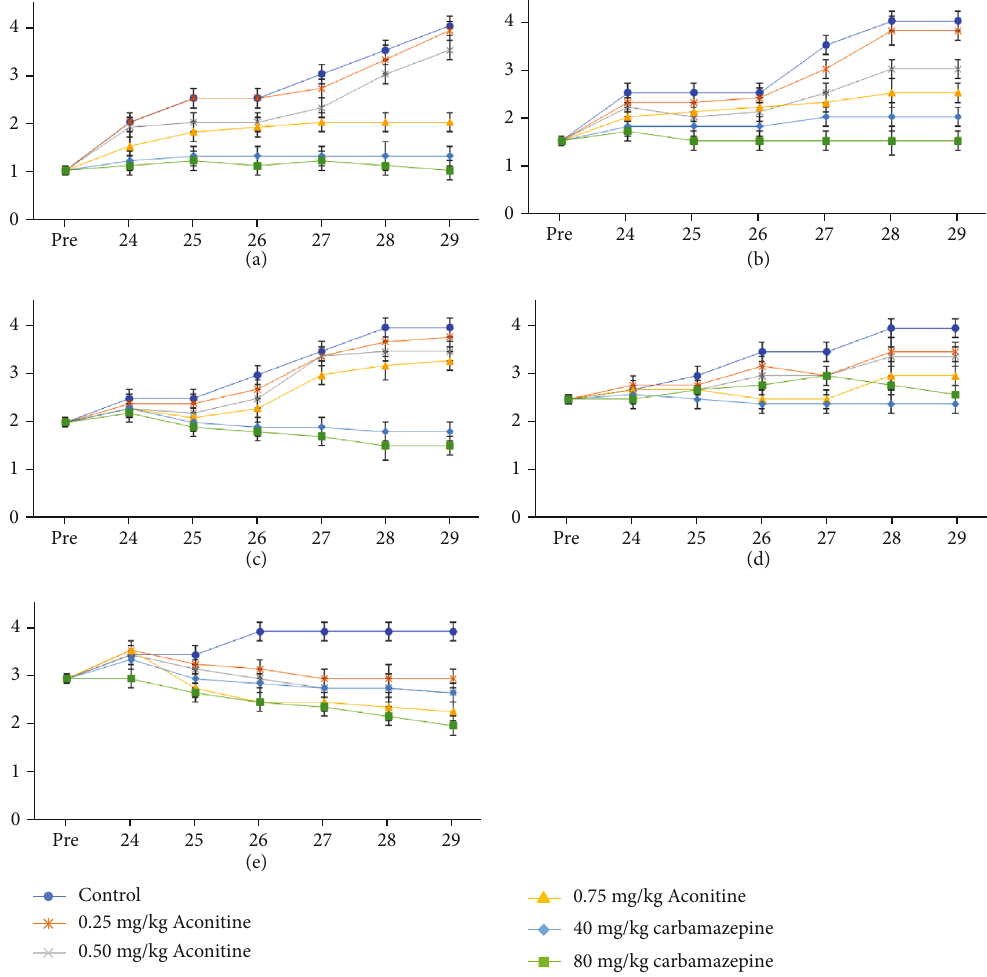
Figure 1: Response levels given to ipsilateral stimulations in behavioral tests with von Frey fi laments with (a) 0.015, (b) 0.127, (c) 0.217, (d) 0.745, and (e) 2.150g bond strength ( x axis represents days, y axis represents